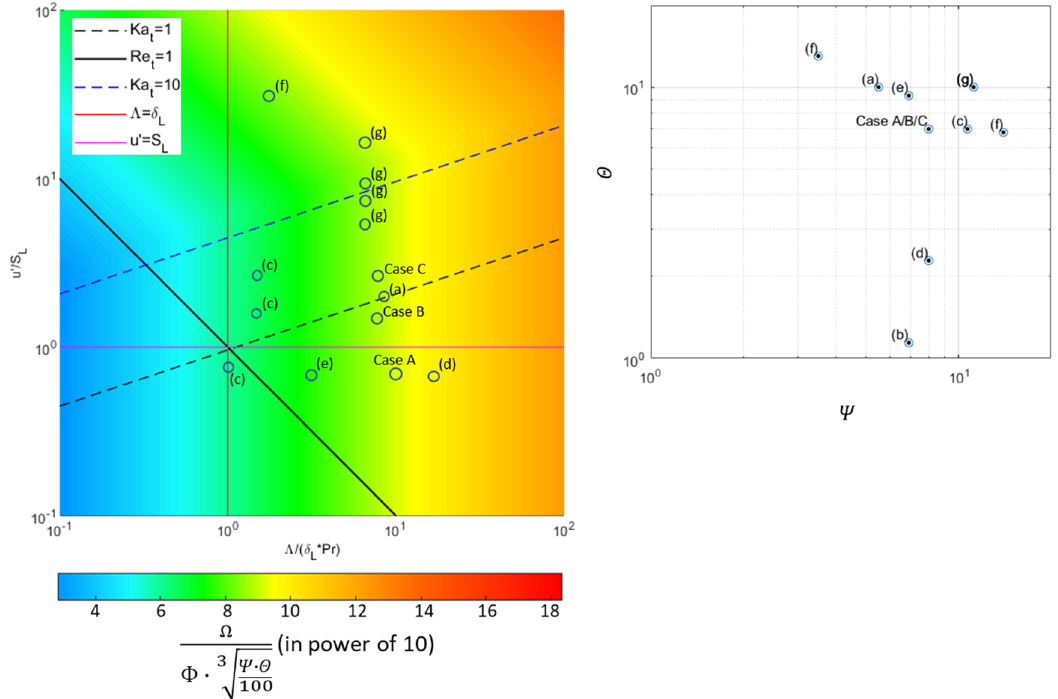
Figure 6. Left: Adapted regime diagram with coloured visualisation of normalised mesh sizes based Figure 6. ( Left ): Adapted regime diagram with coloured visualisation of normalised mesh sizes on Equation (21). The considered 𝑃𝑟 is the characteristic value from within the flame according to based on Equation (21). The considered Pr is the characteristic value from within the flame according the definition in Section 3.3. Different works with different 𝑃𝑟 are noted. Right: Flame front reso ‐ to the definition in Section 3.3. Different works with different Pr are noted. ( Right ): Flame front lutions and domain to Eddy size ratios in different works. resolutions and domain to Eddy size ratios in different